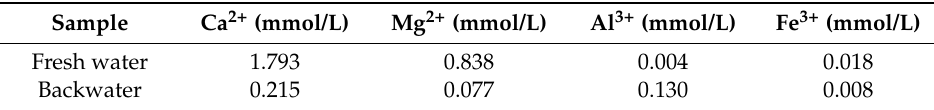
Table 2. Inductively coupled plasma (ICP) measurement results of backwater.